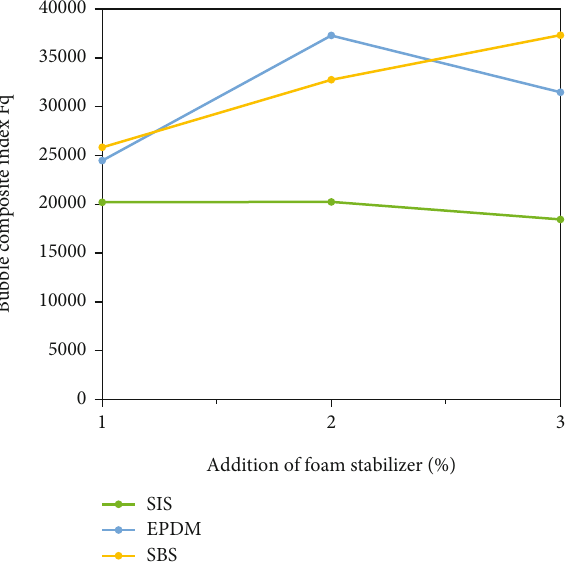
Figure 8: Foam stabilization performance of di ff erent oil-based foam